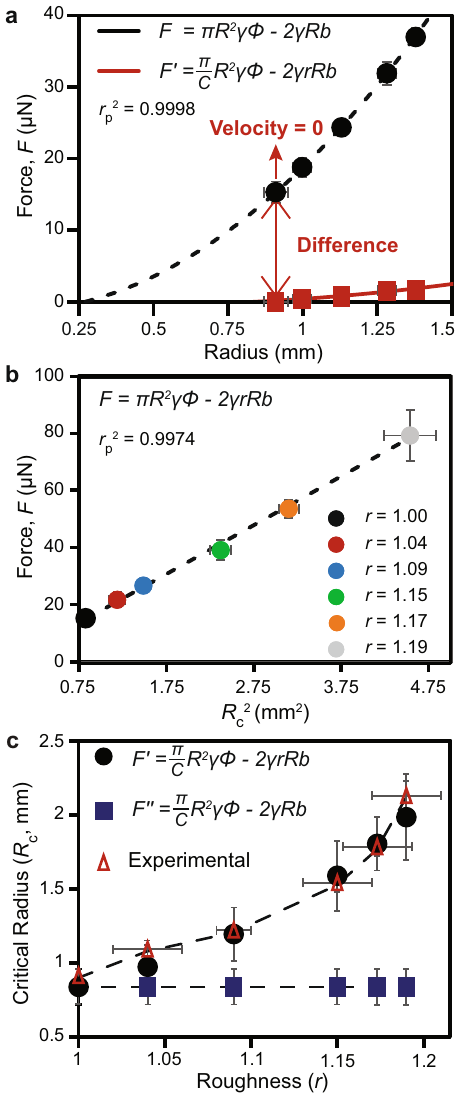
Fig. 2 Force balance and the relationship between Critical Radius and Roughness. a Microdroplet force analysis on a smooth surface gradient highlighting the difference between equation 4 (black data points) and experimental observations ( F ′ , red data points). Both data sets were fi tted to a second order polynomial (black and red traces respectively). b Force differences plotted against R 2 (Pearson ’ s correlation coef fi cient of the linear c regression is denoted as r 2 ). N = 5 for each data point, data reported as (cid:1) x ± p s where (cid:1) x is the mean and s is the standard deviation. The error in force measurements were obtained following the propagation of uncertainty using equation (4). c Comparison of the predicted and experimental critical radii ( R c ) at various roughness states ( r ). Shown are the reduced driving force model ( F ′ , Eq. (7)), the reduced driving force model without roughness ( F ′′ ), and the experimental